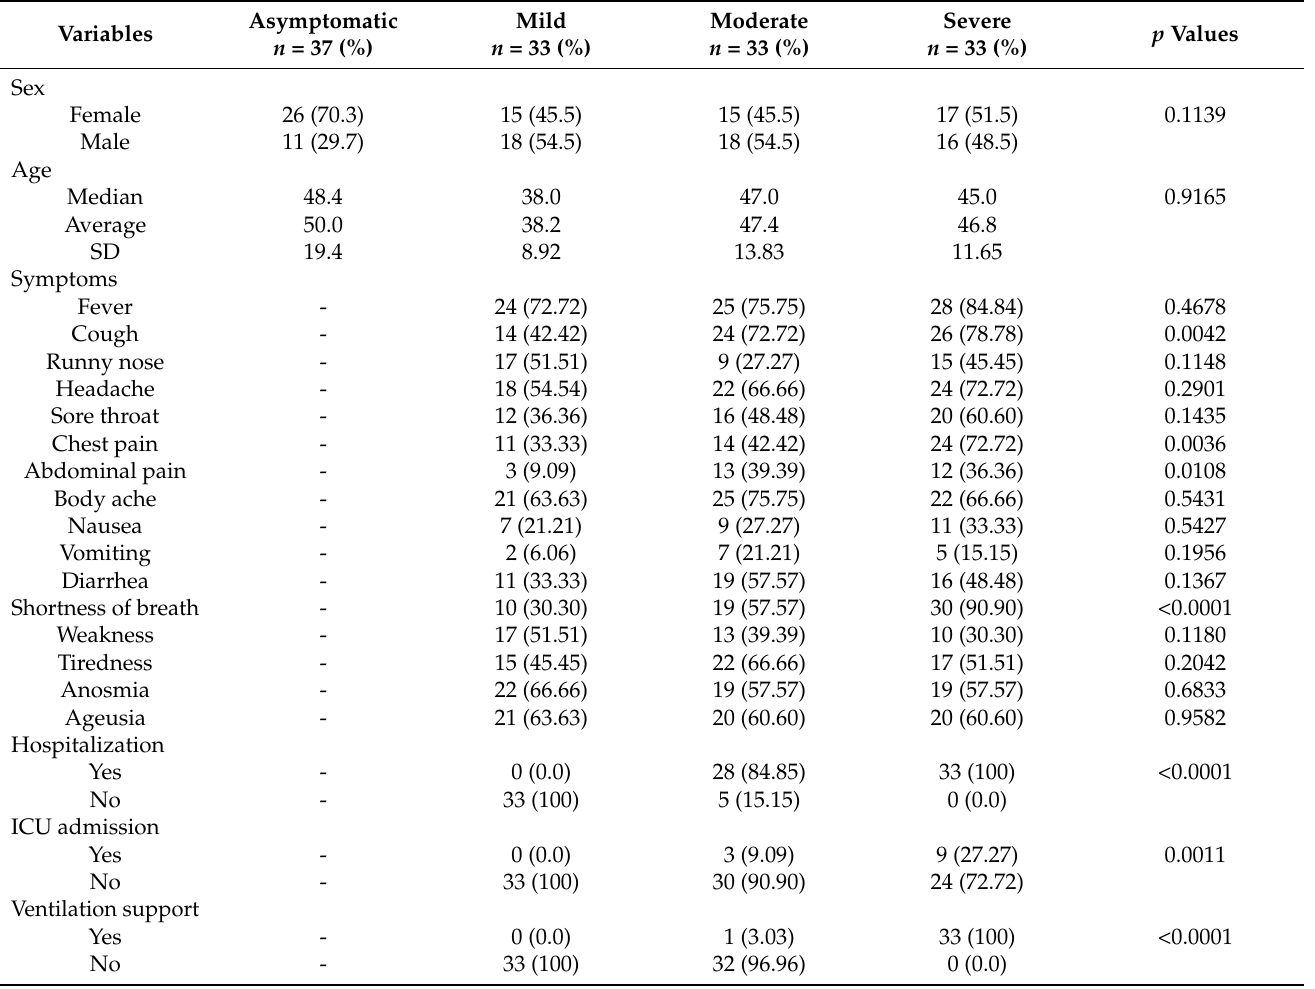
Table 1. Clinical-demographic characteristics of patients infected with